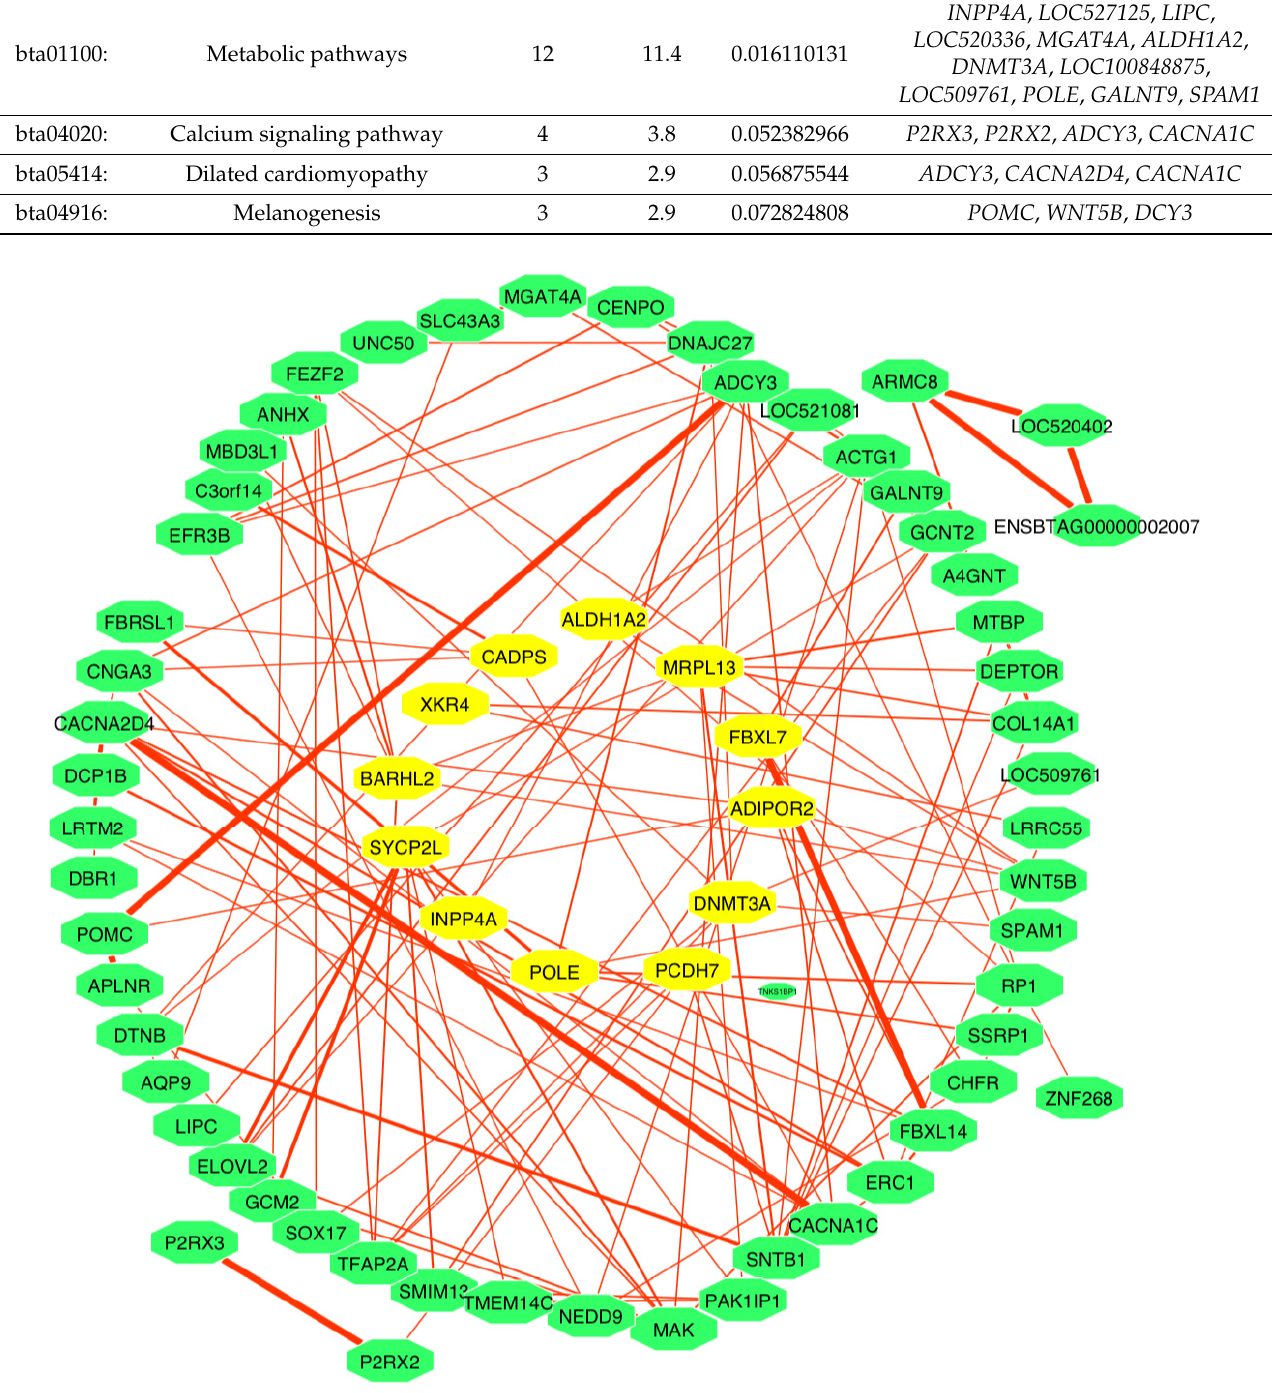
Figure 6. Gene interaction network for genes associated with feet and leg traits in Chinese Holstein cattle. (The nodes in yellow represent the significant candidate genes and their interacting partners).